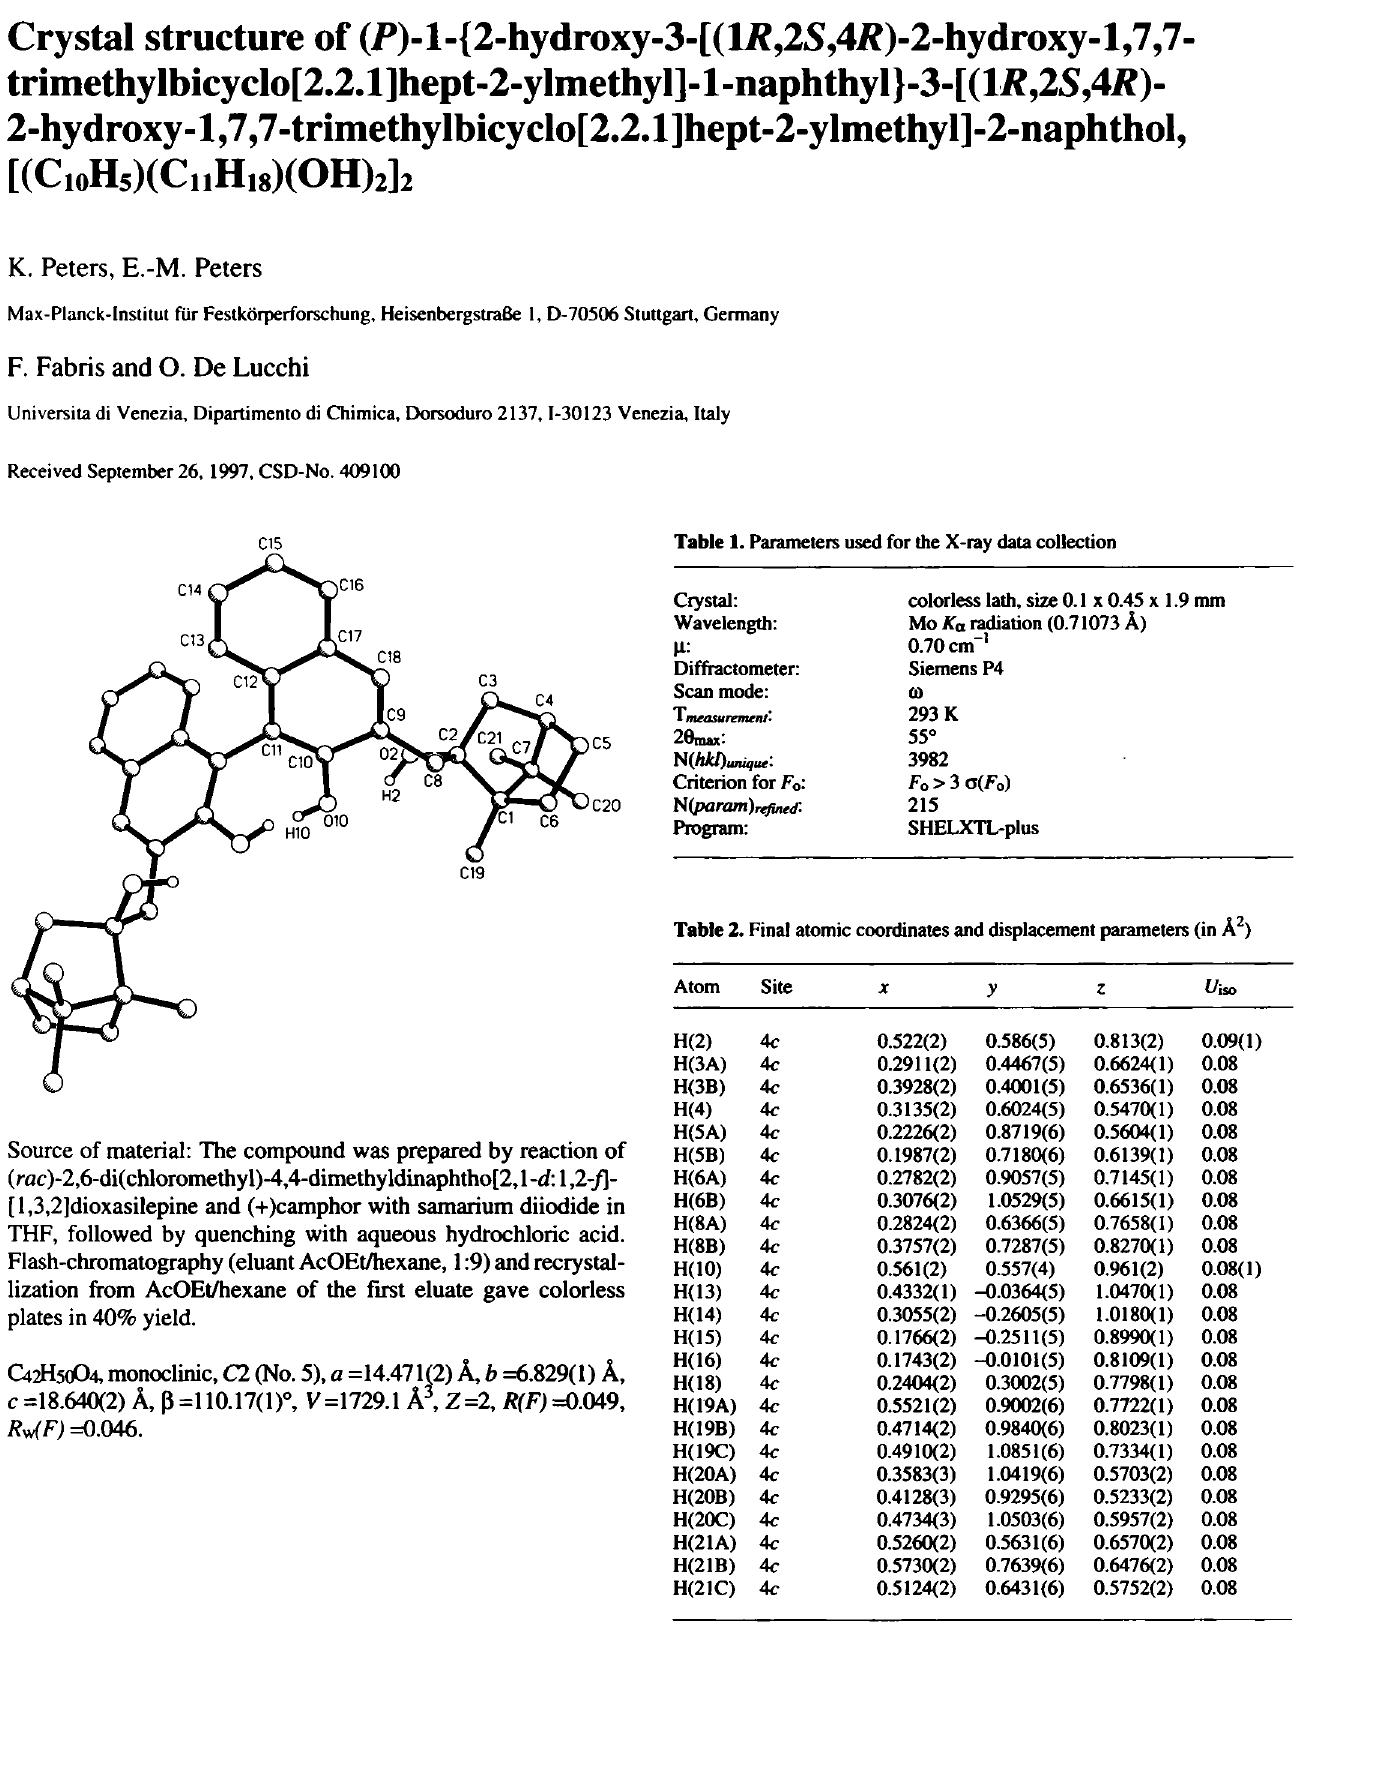
Table 2. Final atomic coordinates and displacement parameters (in